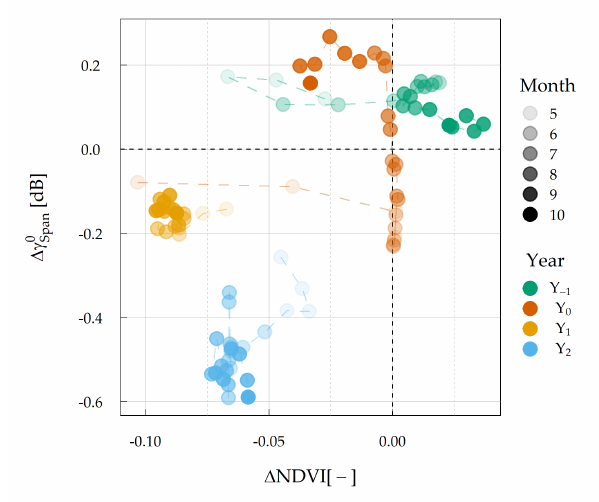
Figure 11. Anomaly time lag between NDVI and S-1 Span backscatter ( γ 0 hysteresis. Time steps are S-1 acquisitions and nearest neighbor S-2 NDVI values, depicted in different transparency levels per month-of-year. The chain-like alignment of observations is an effect of autocorrelation with temporal speckle filtering (S-1) or interpolation (S-2). SAR data processed with temporal ENL = 13, growth season data